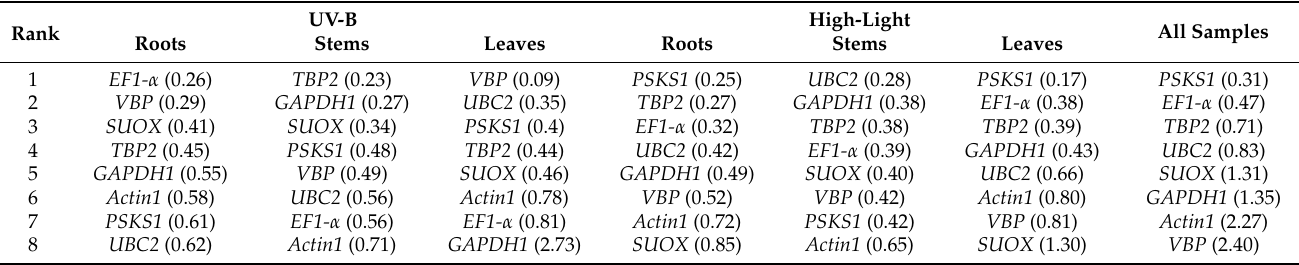
Table 3. Expression stability of eight reference genes under UV-B and high-light stresses according to the NormFinder analysis results.